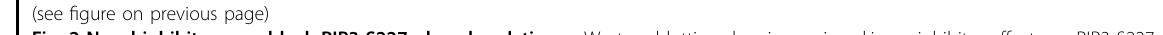
Fig. 2 Novel inhibitors can block RIP3 S227 phosphorylation. a Western blotting showing various kinase inhibitor effects on RIP3 S227 auto- phosphorylation. HT-29 cells were treated with four tested kinase inhibitors (1308, 1336, 1338, and 1371, 10 μ M) for 9 h. As a control, KK5101 (Trk alpha inhibitor) and HS829 (IKK beta inhibitor) were also treated at a concentration of 10 μ M for 9 h. Prototypical necroptosis stimuli (TNF + zVAD + either cycloheximide or SMAC mimetic; hereafter referred to as TCZ or TSZ) were applied for 6 h. Cell lysates were analyzed with a S227 speci fi c p-RIP3 antibody. b Four tested kinase inhibitors displayed kinase inhibitory effects on basal levels of RIP3 auto-phosphorylation in a dose-dependent manner. HT-29 cells were treated with indicated concentrations for 9 h, and cell lysates were analyzed by immunoblotting. c Four tested kinase inhibitors showed small amounts of cytotoxicity in a dose-dependent manner. HT-29 cells were treated with 4 tested kinase inhibitors for 24 h, and cell viability was analyzed by MTT assay or phase-contrast microscopy. The results are presented as means ± SEM. * P < 0.05, ** P < 0.01, *** P < 0.001. d Various necroptosis inhibitors blocked TNF-induced RIP3 phosphorylation. HT-29 cells were pretreated with necrostatin-1 (Nec-1, 40 μ M), dabrafenib (DAB, 10 μ M) or necrosulfonamide (NSA, 1 μ M) for 2 h and then treated with TSZ for 6 h. Cell lysates were analyzed by immunoblotting. e HS-1371 ef fi ciently blocked TNF-induced RIP3 phosphorylation. HT-29 cells were pretreated with four tested kinase inhibitors for 2 h and